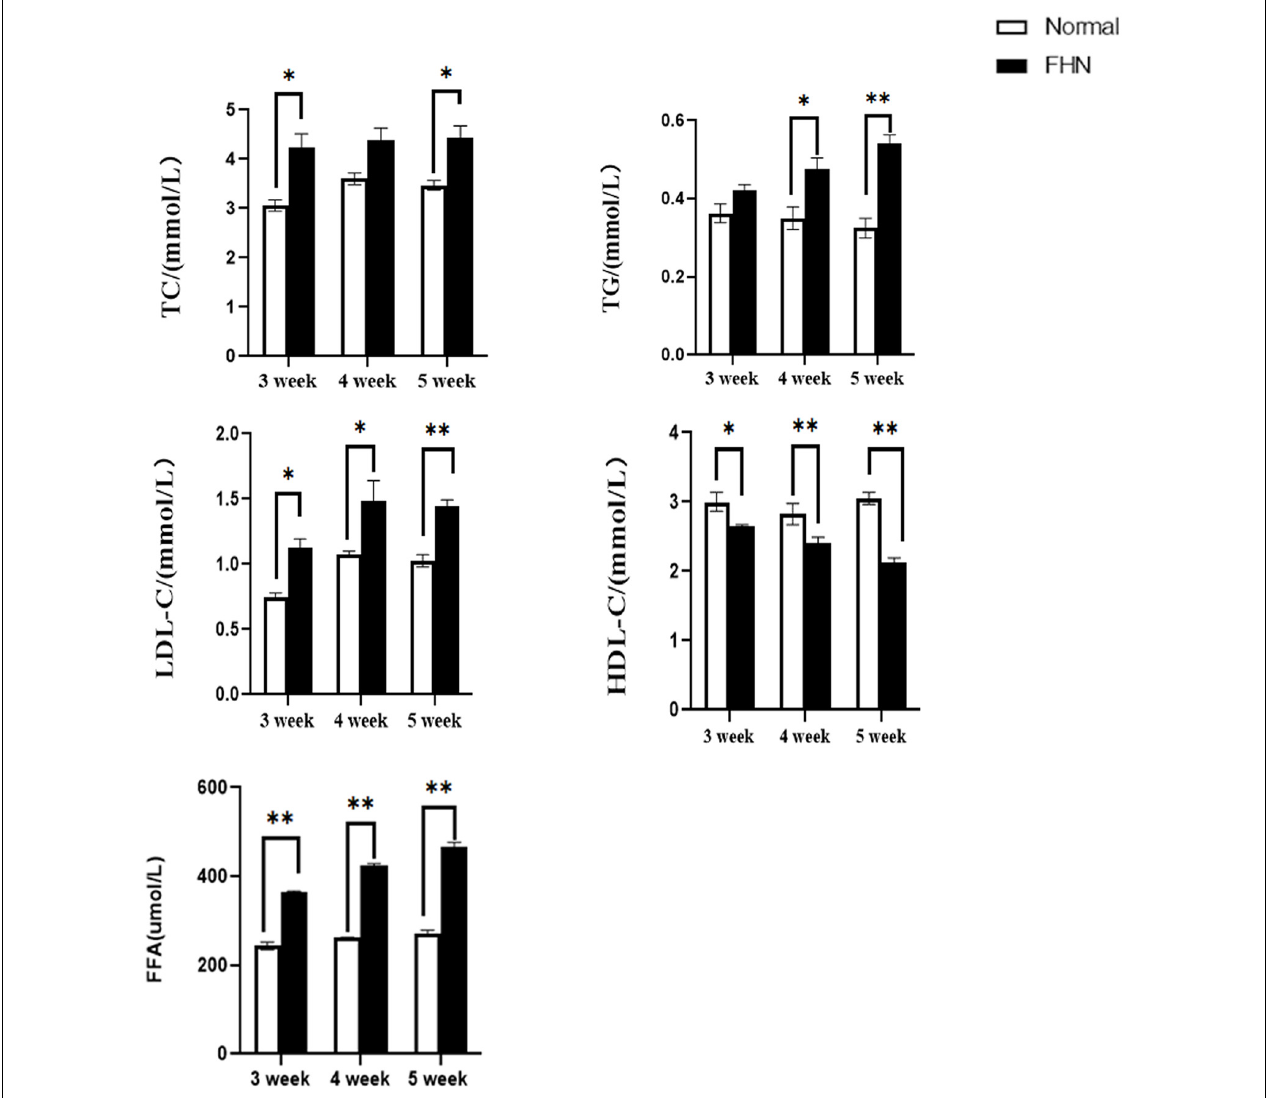
FIGURE 7 | The changes in serum biochemical indicators regarding lipid metabolism. ∗ indicates a significant difference ( P < 0.05). ∗∗ indicates an extremely significant difference ( P < 0.01).